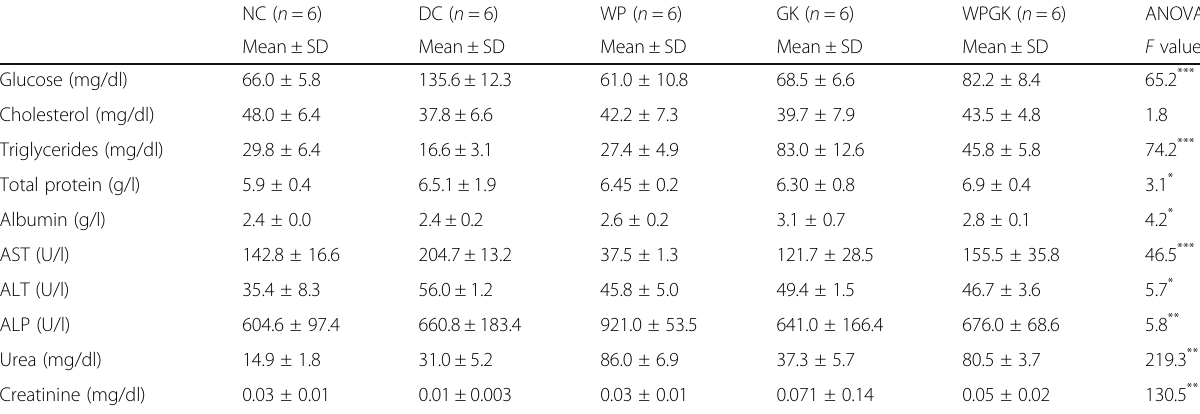
Table 4 Mean ± SD of biochemical markers of diabetic rats fed on whey protein, G. kola, and their